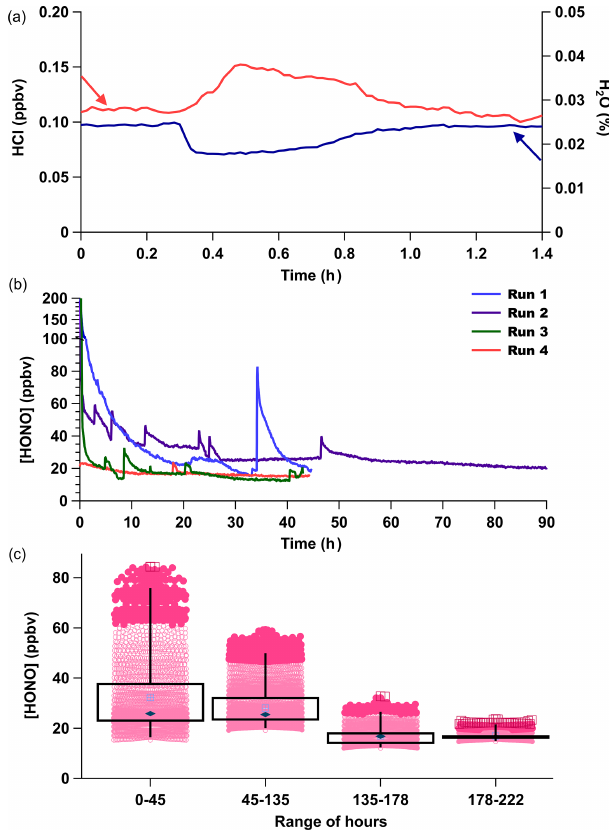
Figure 4. (a) CRDS high-resolution observation for an HCl emis- sion pulse (red) and H 2 O decrease (blue) from PD-6a resulting in a 50% increase in the HCl mixing ratio emitted. (b) Time series of four consecutive measurement periods of HONO production, using only PD-6c and a new NaNO 2 -coated reaction device in each run. (c) Box (first and third quartile) and whiskers (3 σ from the mean) of HONO mixing ratios observed for the four runs are binned by duration of use for each new reaction device in hours. Mean values are indicated with a filled dark blue diamond marker, median val- ues by the light blue crossed box marker, dark pink circles are 2 σ outliers, and dark red squares 3 σ outliers.